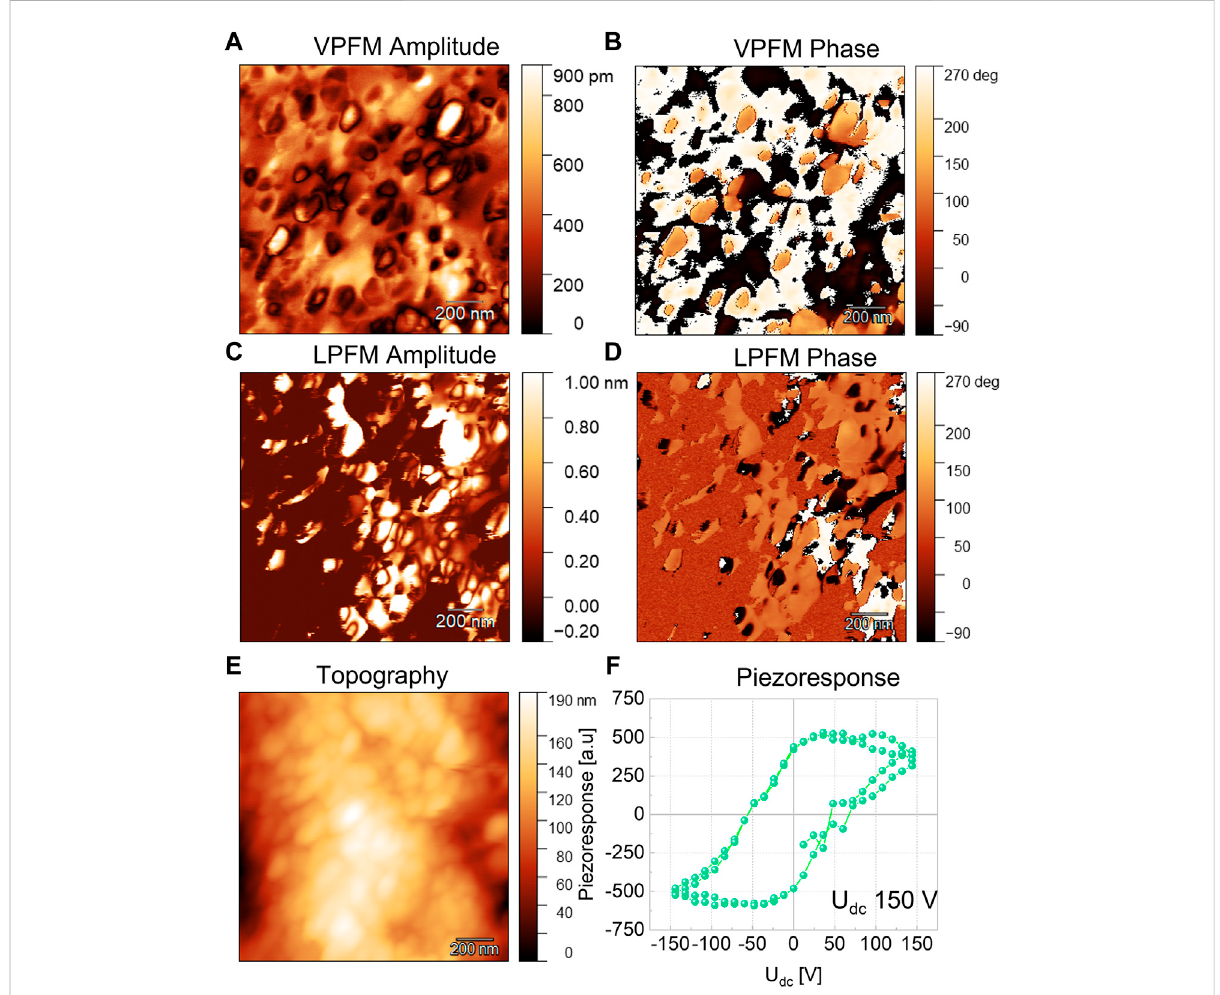
FIGURE 4 Representative PFM results for NdandMn co-doped BFONPs. The vertical PFMamplitude (A) ,and phase (B) ,thelateral PFMamplitude (C) ,and phase (D) images. The topography of NPs (E) and a local piezoresponse hysteresis loop (F) .